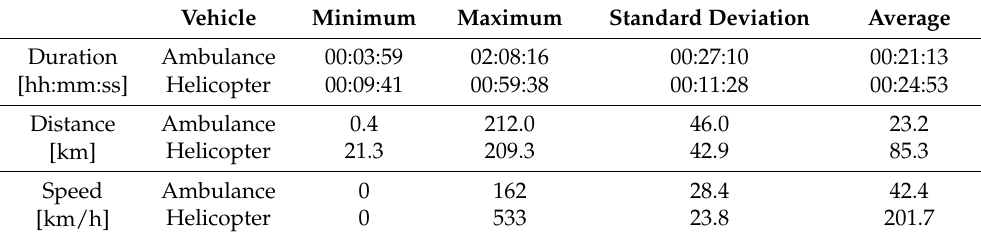
Table 1. Trips characteristics—ambulance (39), helicopter (29).